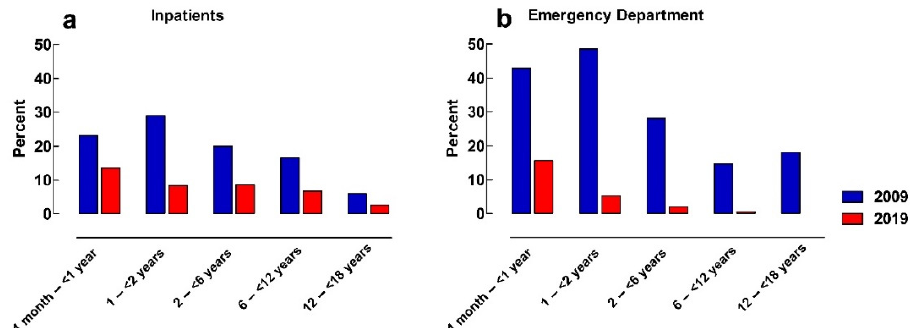
Figure 4. Frequency of patients with manipulated solid rectal medicines in different age-groups in: ( a ) inpatients; ( b ) patients at the emergency department. Inpatients in 2009 mainly received parts of solid rectal preparations from the ATC groups M (musculoskeletal system) and N (nervous system) and, in 2019, from the therapeutic groups A (alimentary tract) and N (nervous system) (Figure 5a). At the emergency department, a more pronounced increase in manipulation of ATC group A (alimentary tract) was seen between 2009 and 2019, and a similar decrease in manipulation of M (musculoskeletal system) as was seen for inpatients (Figure 5b). ATC groups M and N (musculoskeletal and nervous system) mostly contains suppositories; in ATC group A (alimentary tract), most preparations are enemas.